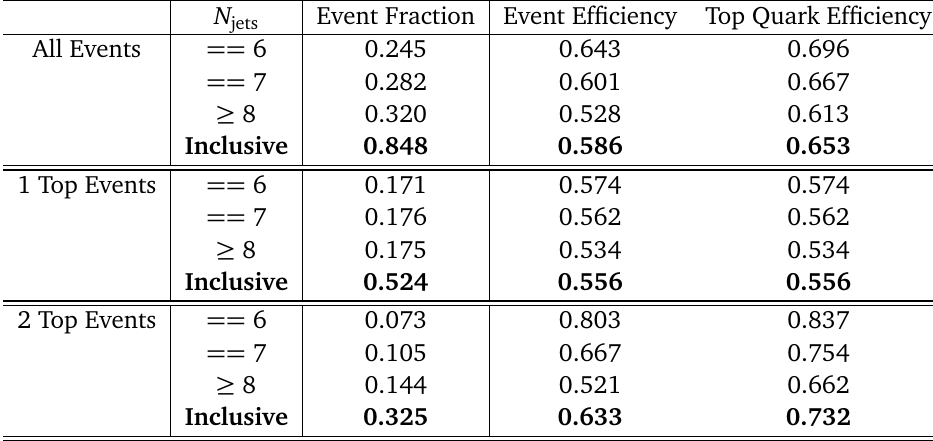
Table 6: S PA -N ET results on t ¯ t using Pythia